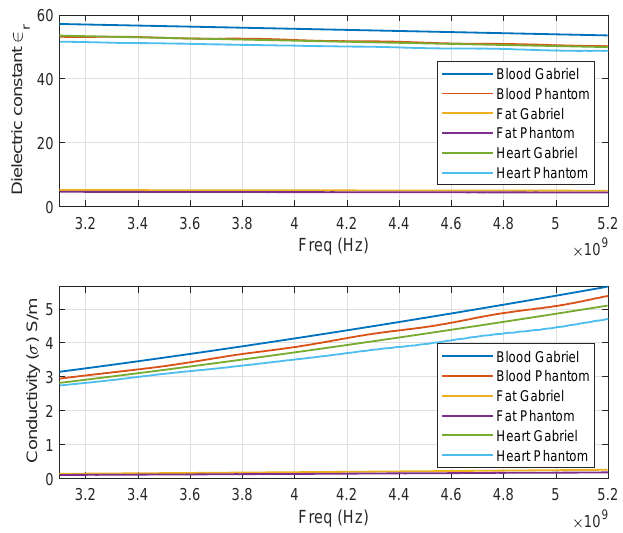
Figure 6. Dielectric Properties of UWB